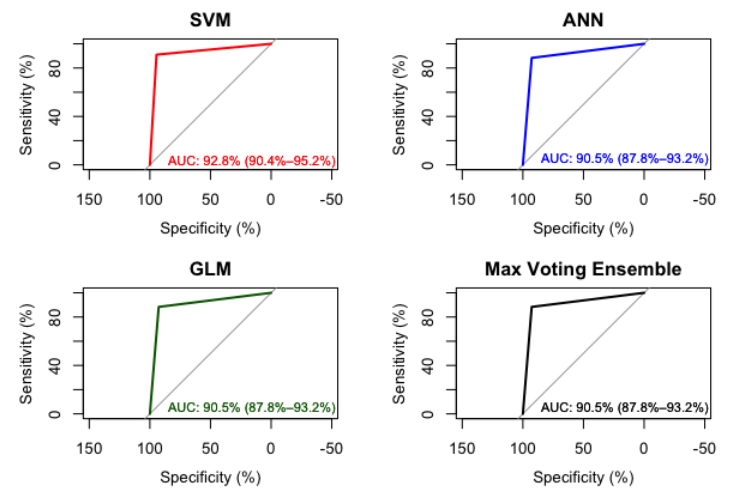
Figure 3. AUC in SVM, ANN, GLM and Ensemble